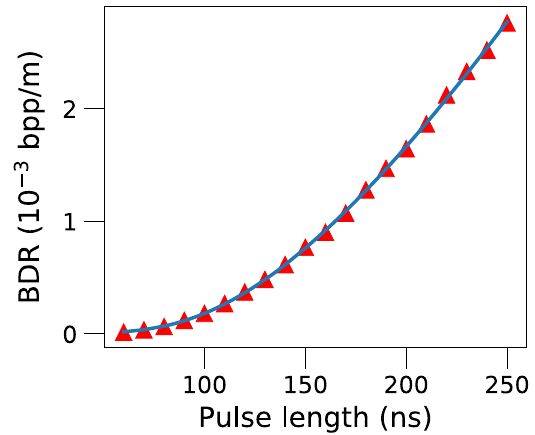
FIG. 14. BDR as a function of the pulse length, t nominal set of parameters and an electric field of 250 MV = m, found from the numerical simulations (triangles). The line is a fit to Eq.